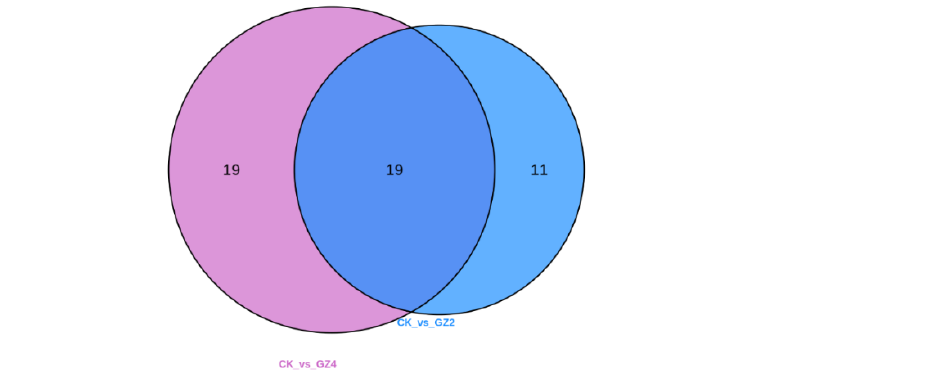
Figure 6. Venn diagram showing the numbers of metabolites in GZ2 vs. CK and GZ4 vs. CK. Table 1. T he 49 differential flavonoid metabolites in GZ2 vs. CK and GZ4 vs. CK.